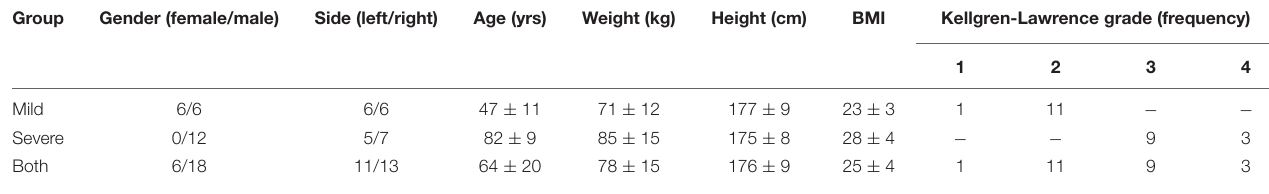
TABLE 1 | Summary of demographic specimen data for each group (age, weight, height and body mass index (BMI) reported as mean ± standard deviation) and frequencies of morphological degeneration grades according to Kellgren-Lawrence.